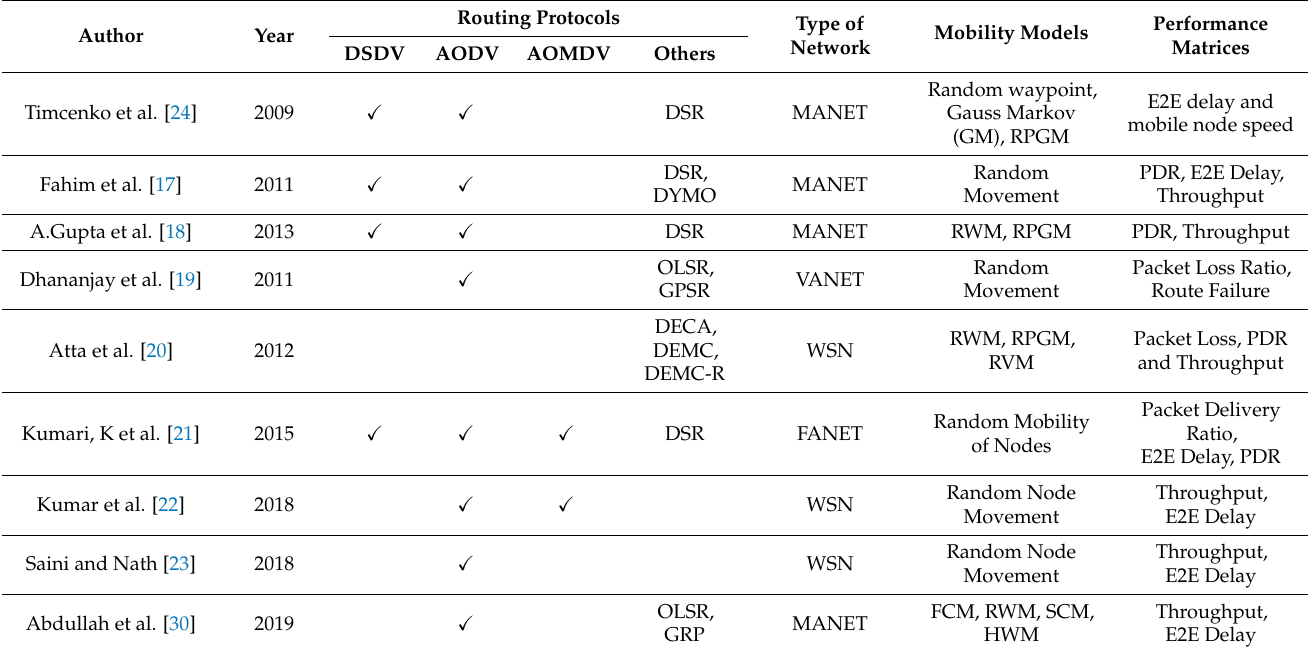
Table 1. Summary of Related